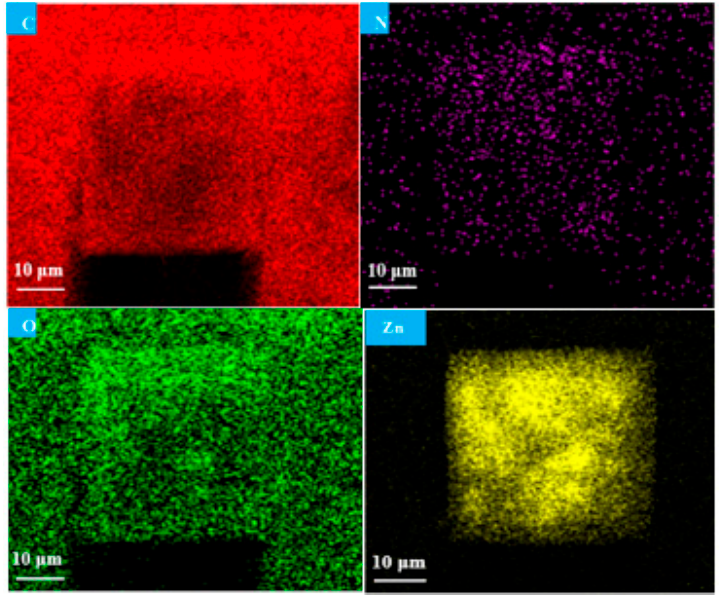
Figure 7. TEM-mapping images of catalysts: MOF5-750.